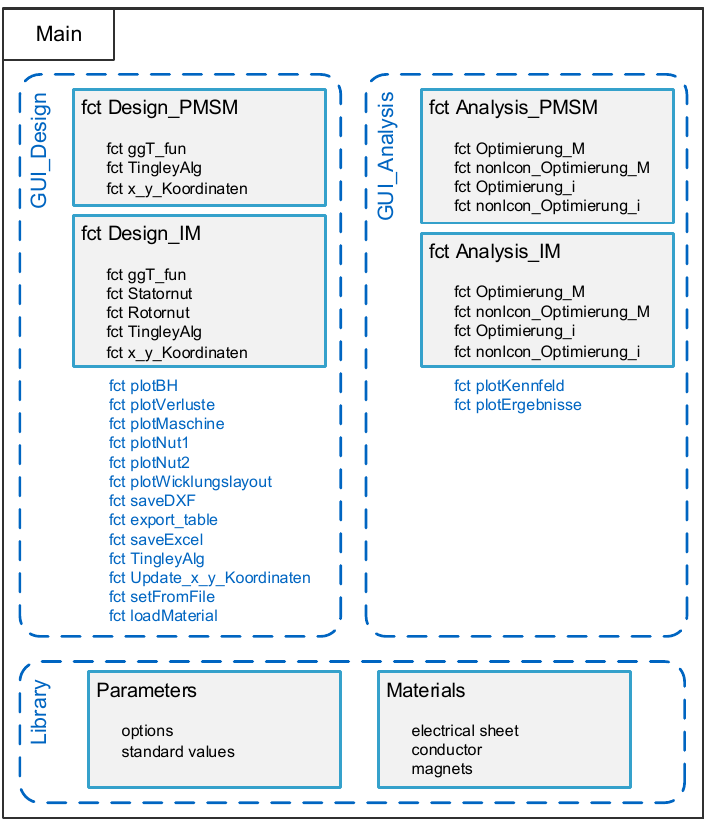
Figure 4. Model structure and functions.